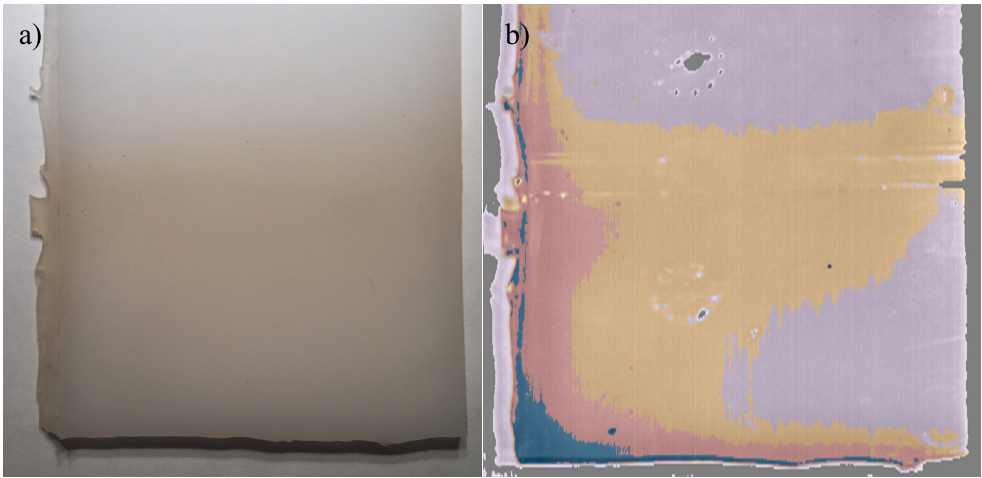
Figure 8. RGB image ( a ), and hyperspectral colormap image showing damaged areas not visible in RGB image ( b ) .